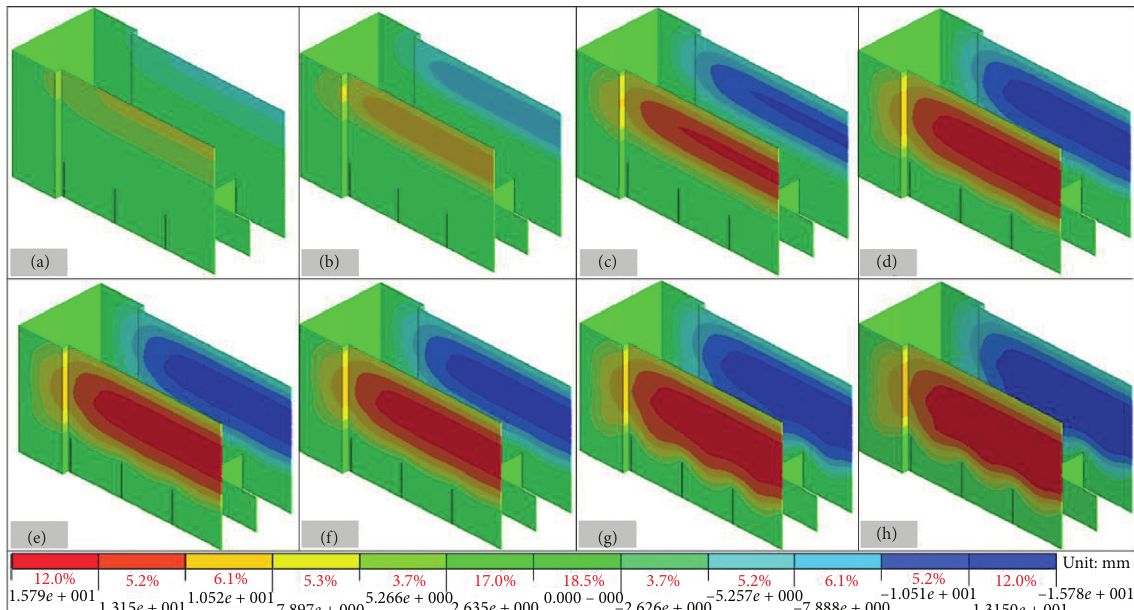
Figure 10: The contour of the lateral wall deflection with 3D-analysis. (a) Step 1, (b) step 2, (c) step 3, (d) step 4, (e) step 5, (f) step 6, (g) step 7, and (h) step